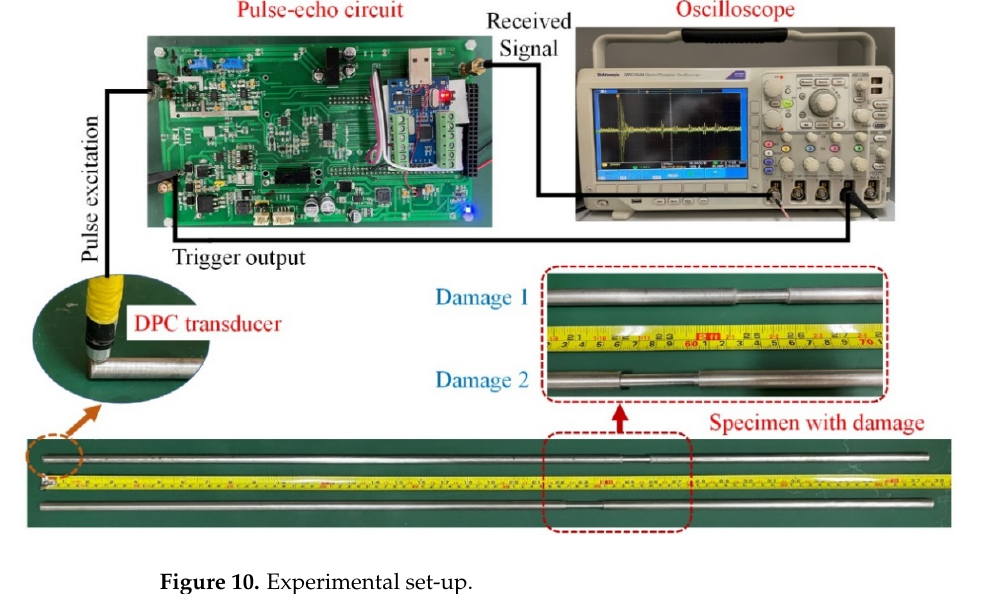
Figure 10. Experimental set-up.